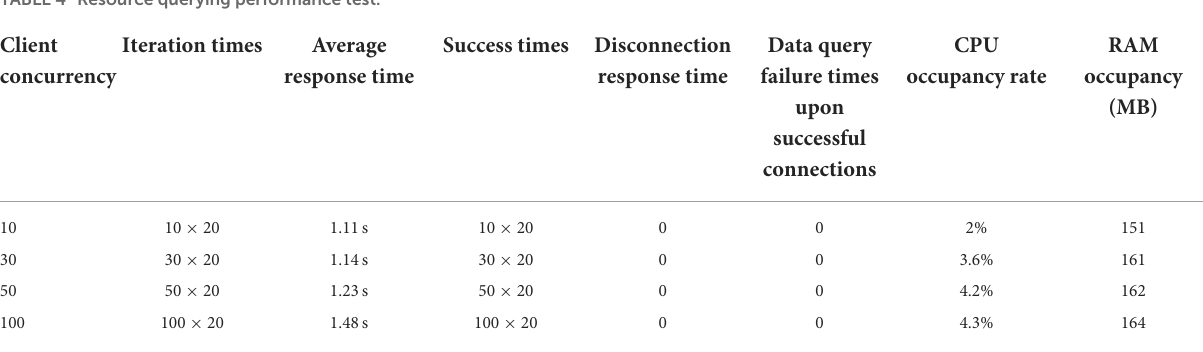
TABLE 4 Resource querying performance